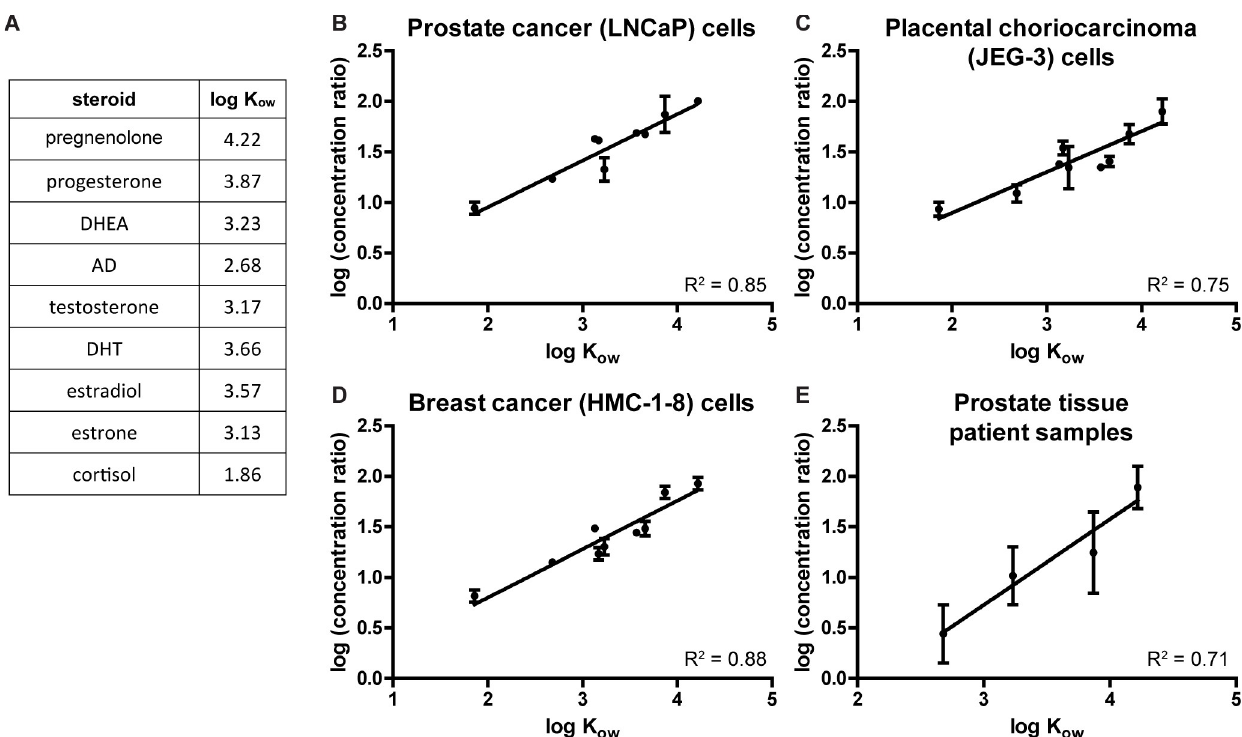
Fig 7. Differences in octanol-water partition coefficients predict differences in cellular uptake of steroids. (A) Experimentally determined log octanol- water partition coefficient (log K ow ) values for nine steroids, obtained from Leszczynski and Schafer [30]. (B-D) Graphs of logs of average cell-to-media concentration ratios (from experiments described in Fig 1 ) vs. log K ow for the same nine steroids, in (B) prostate cancer (LNCaP) cells, (C) placental choriocarcinoma (JEG-3) cells, and (D) breast cancer (HMC-1-8) cells. For each cell line, all steroids were assayed in at least two experiments with biological duplicates; graphs represent mean ± SD of concentration ratios. (E) Graph of logs of average tissue-to-blood concentration ratios (from data described in Fig 4 ) vs. log K ow for pregnenolone, progesterone, DHEA, and AD. Data from twenty prostate cancer patients are included; graph shows mean ± SD of concentration ratios. For all graphs, slopes of trendlines are different from zero (p < 0.0001).